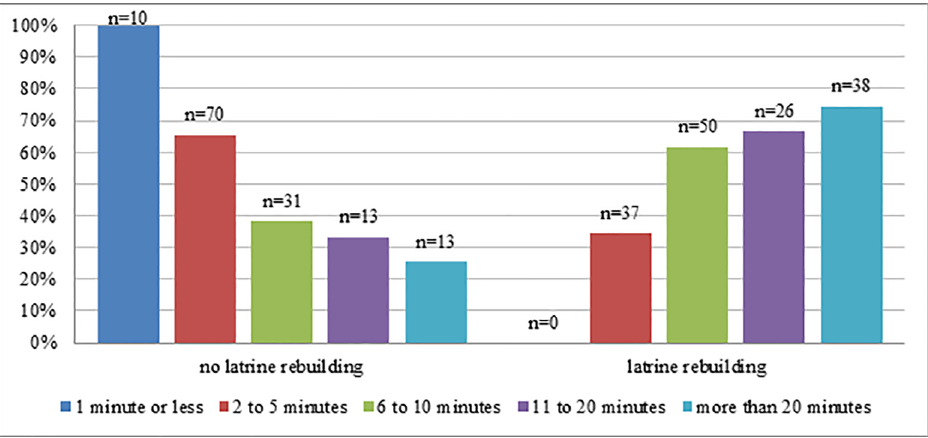
Fig 4. Distance to OD area and latrine rebuilding. Differences in latrine rebuilding related to self-reported walking distance to the nearest potential open defecation